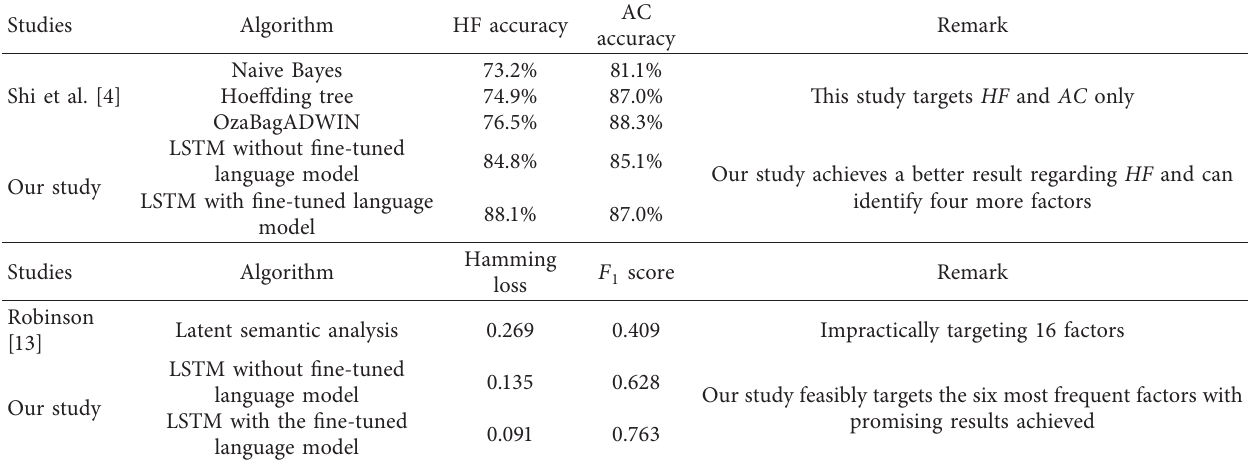
Table 12: A performance comparison of our method with previous research, regarding single-label and multilabel identification. Studies